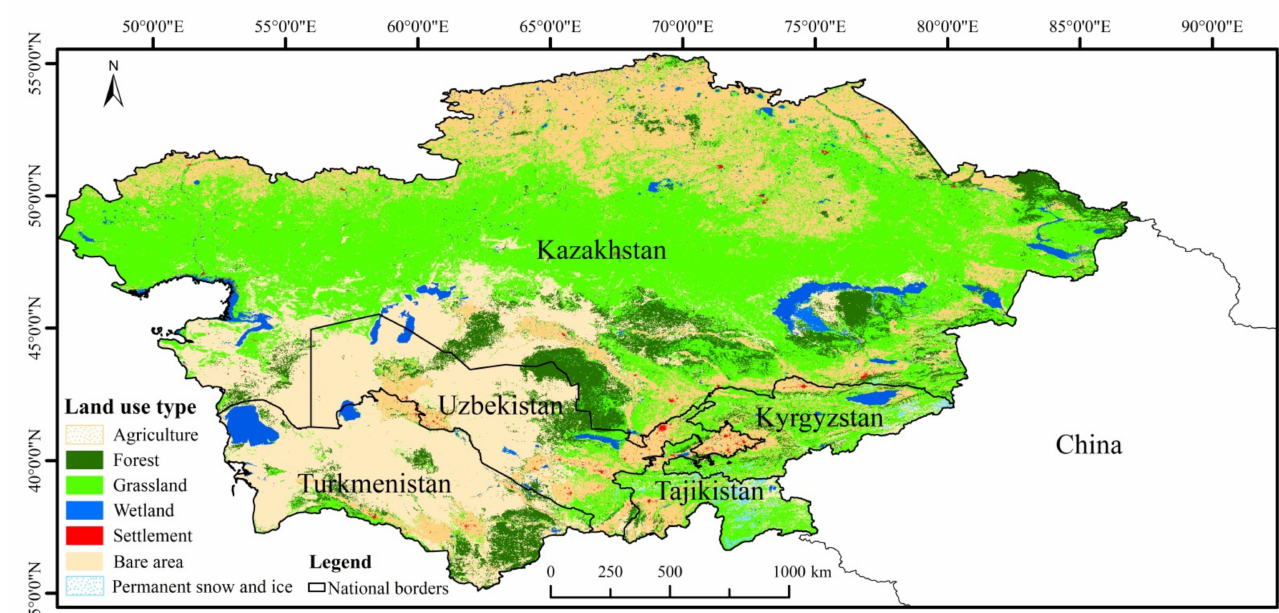
Figure 1. Geographical locations of the